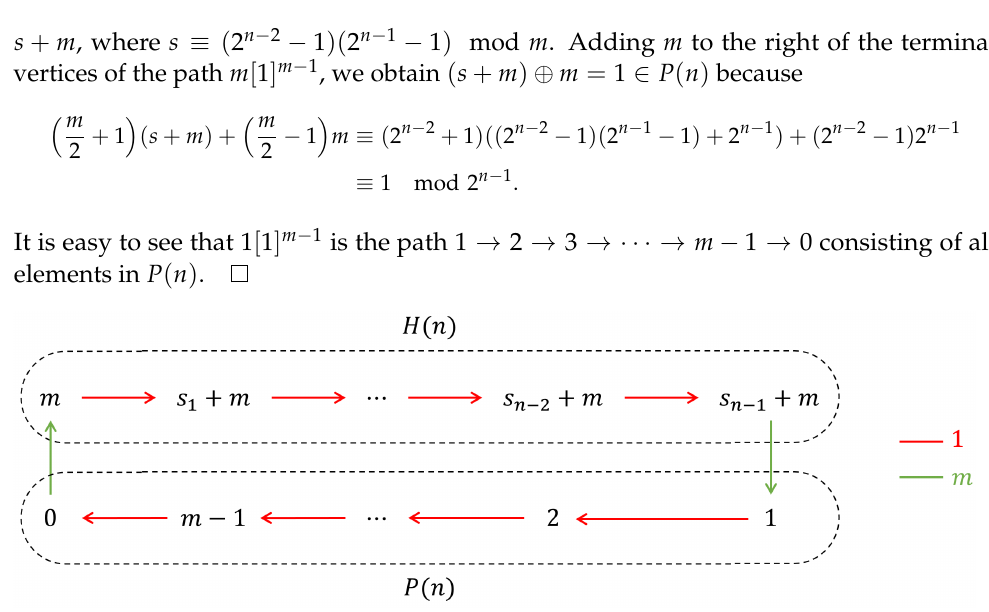
Figure 4. The Hamiltonian cycle in R-Cay ( G ( n ) , { 1, m } ) in the proof of Theorem 7.